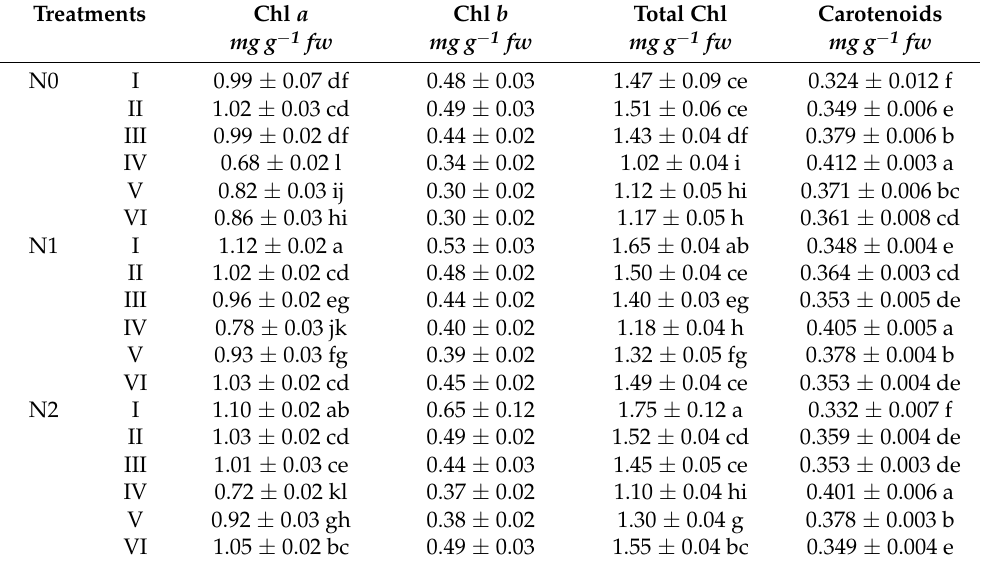
Table 10. Interactions nitrogen fertilization × harvest (F × H) on the average content of chlorophyll a (Chl a ), chlorophyll b (Chl b ), total chlorophyll and carotenoids in rocket. Different letters within each column indicate significant differences at p = 0.05 (Tukey’s test).